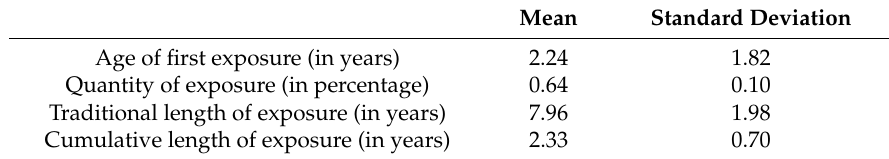
Table 1. Mean and standard deviation (SD) of the exposure factors to Italian of the bilingual